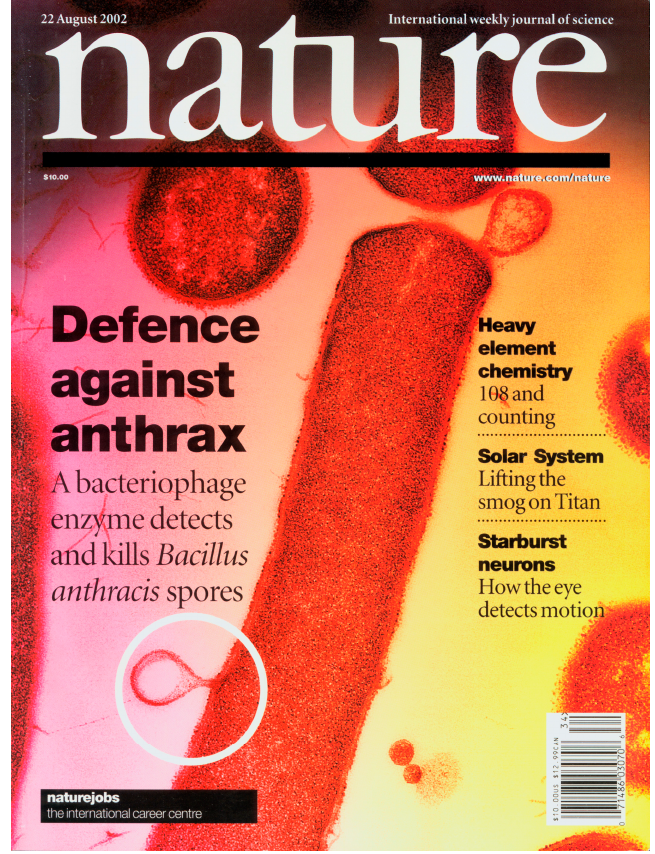
Figure 1. The cover of Nature , 22 August 2002, showing the cover article of a phage lysin against Bacillus anthrax. The cover image is a bacillus after treatment with the PlyG lysin, showing the cytoplasmic membrane externalizing (white circle and at the top of the bacillus).